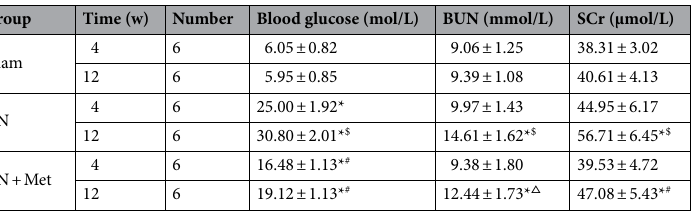
Table 1. Blood glucose and renal function of rats in each group ( n = 6). All data were shown as mean ± SD ( n = 3). BUN: blood urea nitrogen; SCr: serum creatinine; Sham: control group; DN: diabetic nephropathy group; Met: metformin. * P < 0.01 vs. Sham group by ANOVA, #, △ P < 0.01 vs. DN group by ANOVA, $ P < 0.05 vs. 4-week DN and DN + Met group by